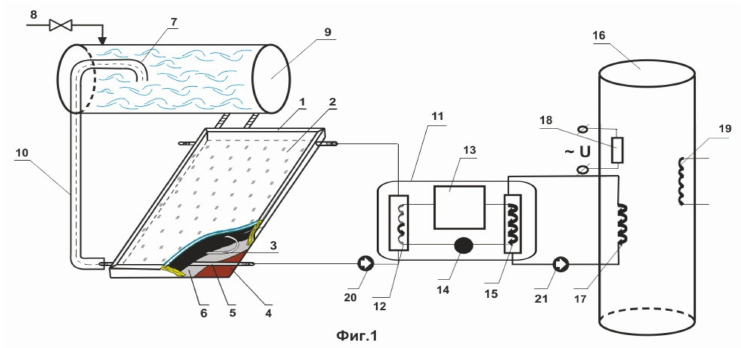
Figure 1. Solar thermal system with